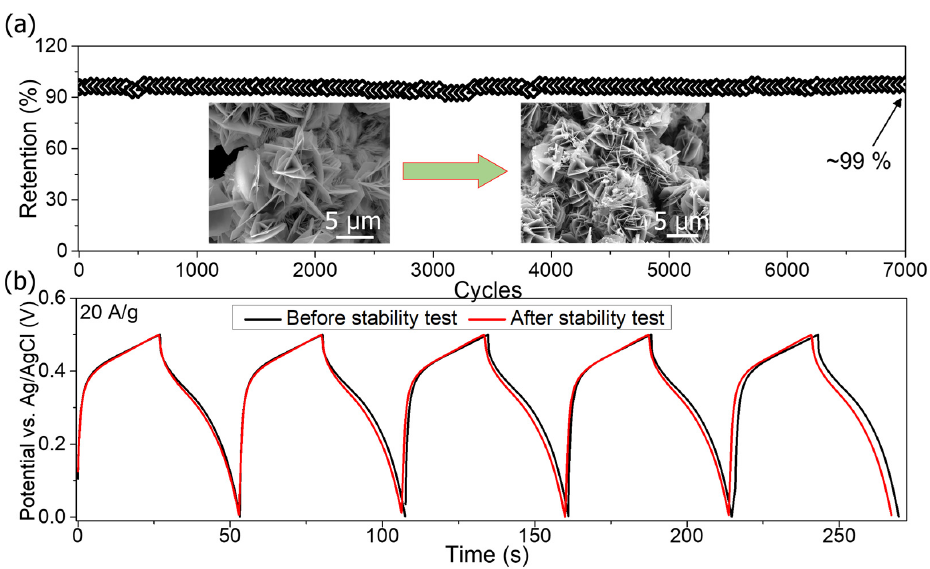
Figure 7. (a ) Cycling stability tests of ZnCoO@NF electrode ( b ) Five GCD cycles before and after stability test. Table 1. Comparisons of the ZnCoO@NF electrode with previous literature in terms of electrode material, capacitance, current density, number of cycles, and retention.